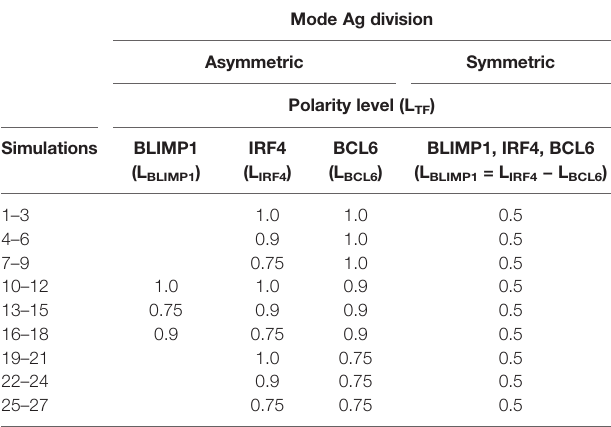
TABLE 3 | Simulated asymmetry of TFs concentrations (P TF = 0.72; polarity levels L BLIMP1 , L IRF4 , and L BCL6 ) in daughter cells after asymmetric